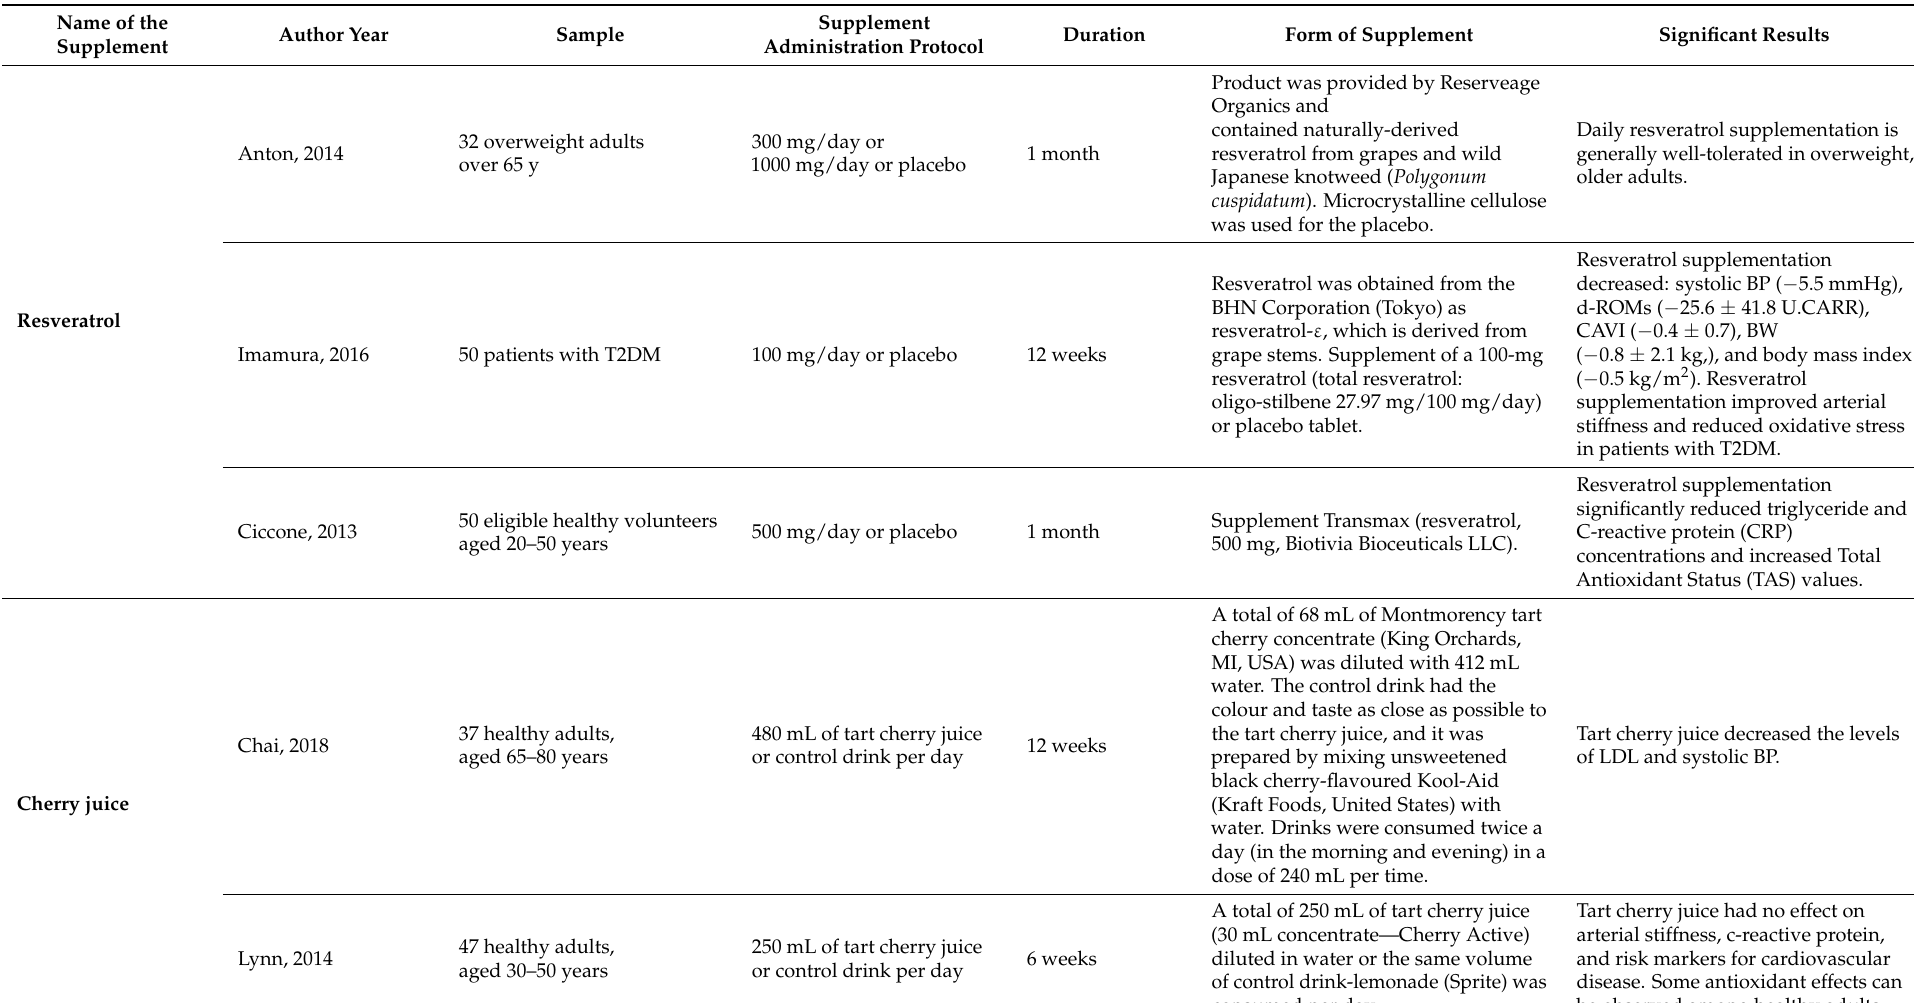
Table 1. All studies included in the meta-analysis ( n =